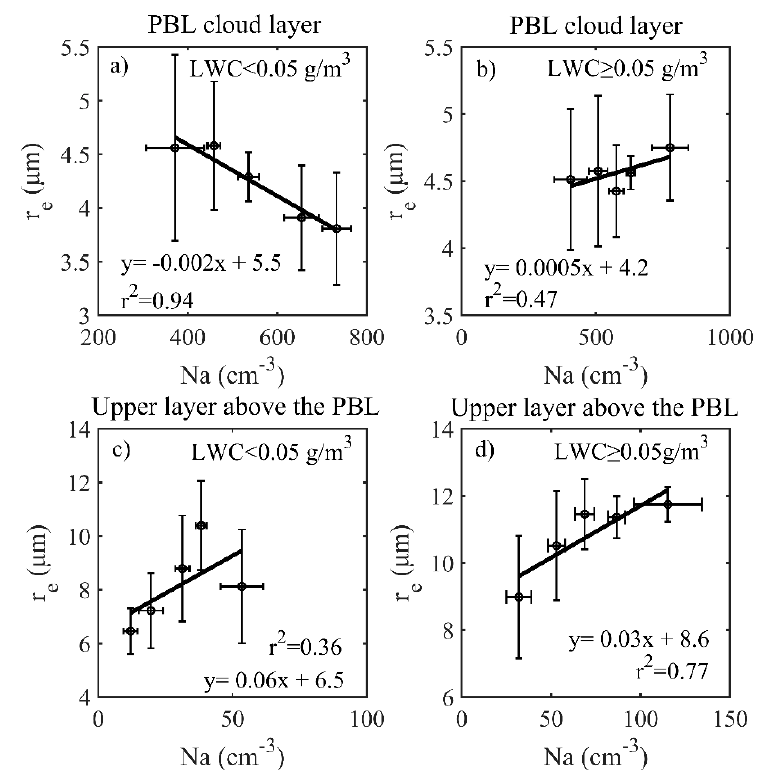
Figure 5. Relationship between cloud droplet r e and aerosol Na for the PBL cloud layer and upper layer above the PBL with two different ranges of LWC: ( a ) PBL cloud layer with LWC < 0.05 g/m 3 ; ( b ) PBL cloud layer with LWC ≥ 0.05 g/m 3 ; ( c ) upper layer above the PBL with LWC < 0.05 g/m 3 , and ( d ) upper layer above the PBL with LWC ≥ 0.05 g/m 3 . The circles and bars represent the means and standard deviations of the examined variables (r e and Na) at each bin of Na. The five bins are classified based on Na with the same sample volume. The fitting lines are all linearly regressed based on the bin averages of Na and r e .